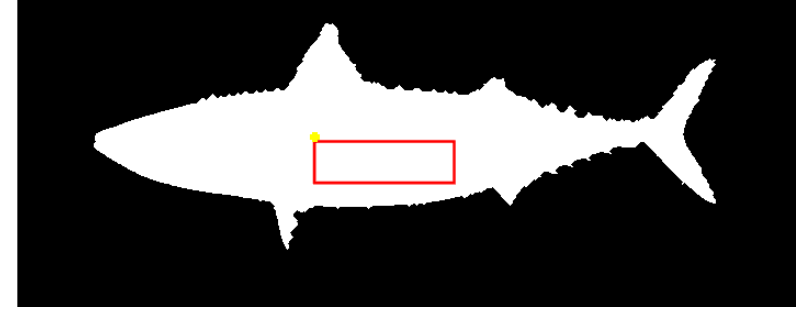
Figure 12. Region where the texture features are extracted, blocked in a red rectangle.